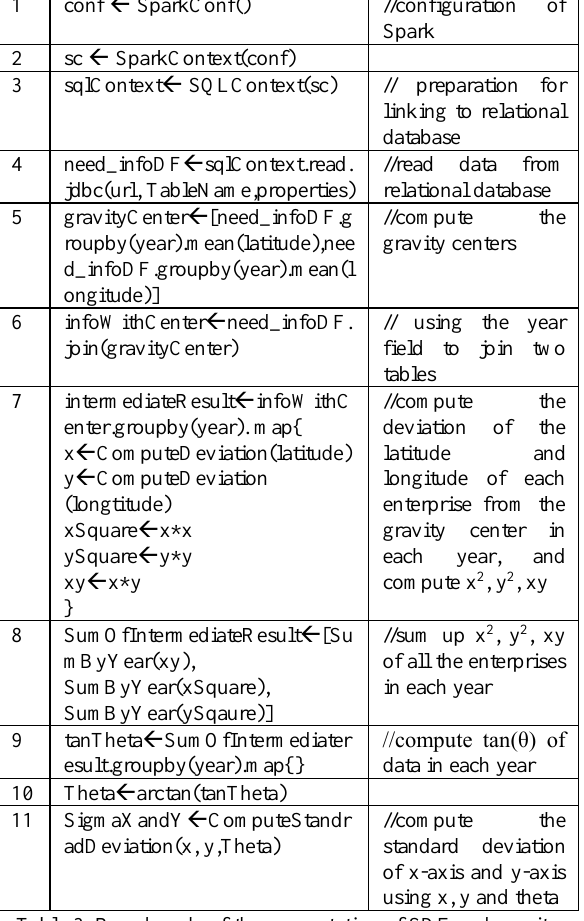
Figure 3. An example of the calculation result of SDE and gravity center organized in JSON format